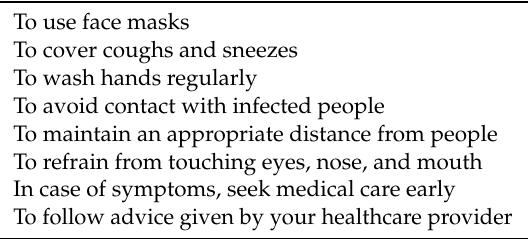
Table 3. Main Corona Virus Disease 2019 (COVID-19) prevention